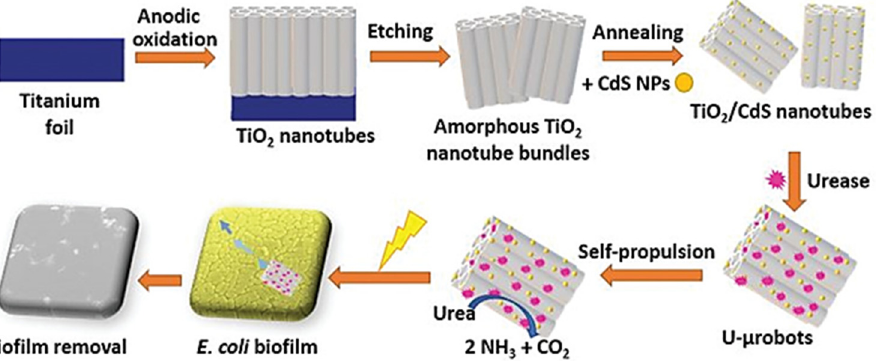
Figure 4. Representation of hybrid photocatalytic TiO 2 /CdS microrobots E. coli biofilm removal. Reprinted from Ref. [65] from an open-access journal of Wiley Publishing.